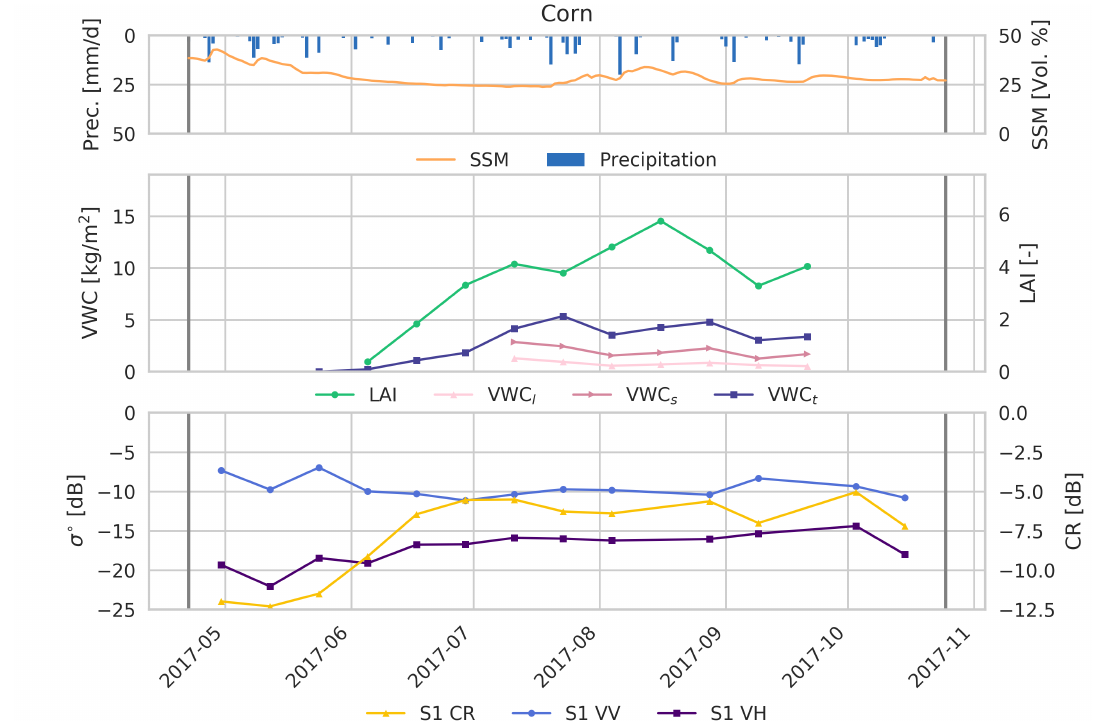
Figure 5. Time series of Sentinel-1 and in situ variables as in Figure 2 for corn